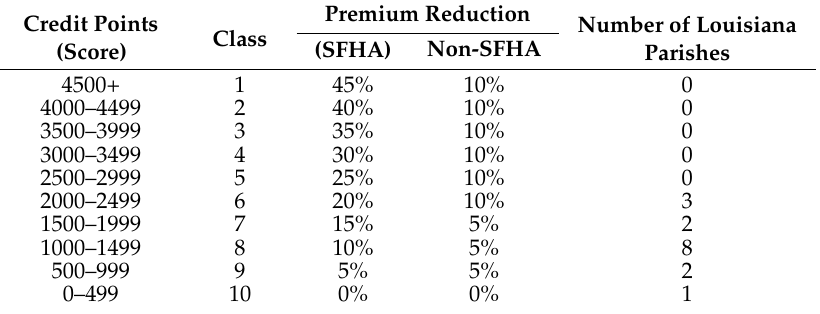
Table 2. The CRS points and classification system [6]. SFHA, Special Flood Hazard